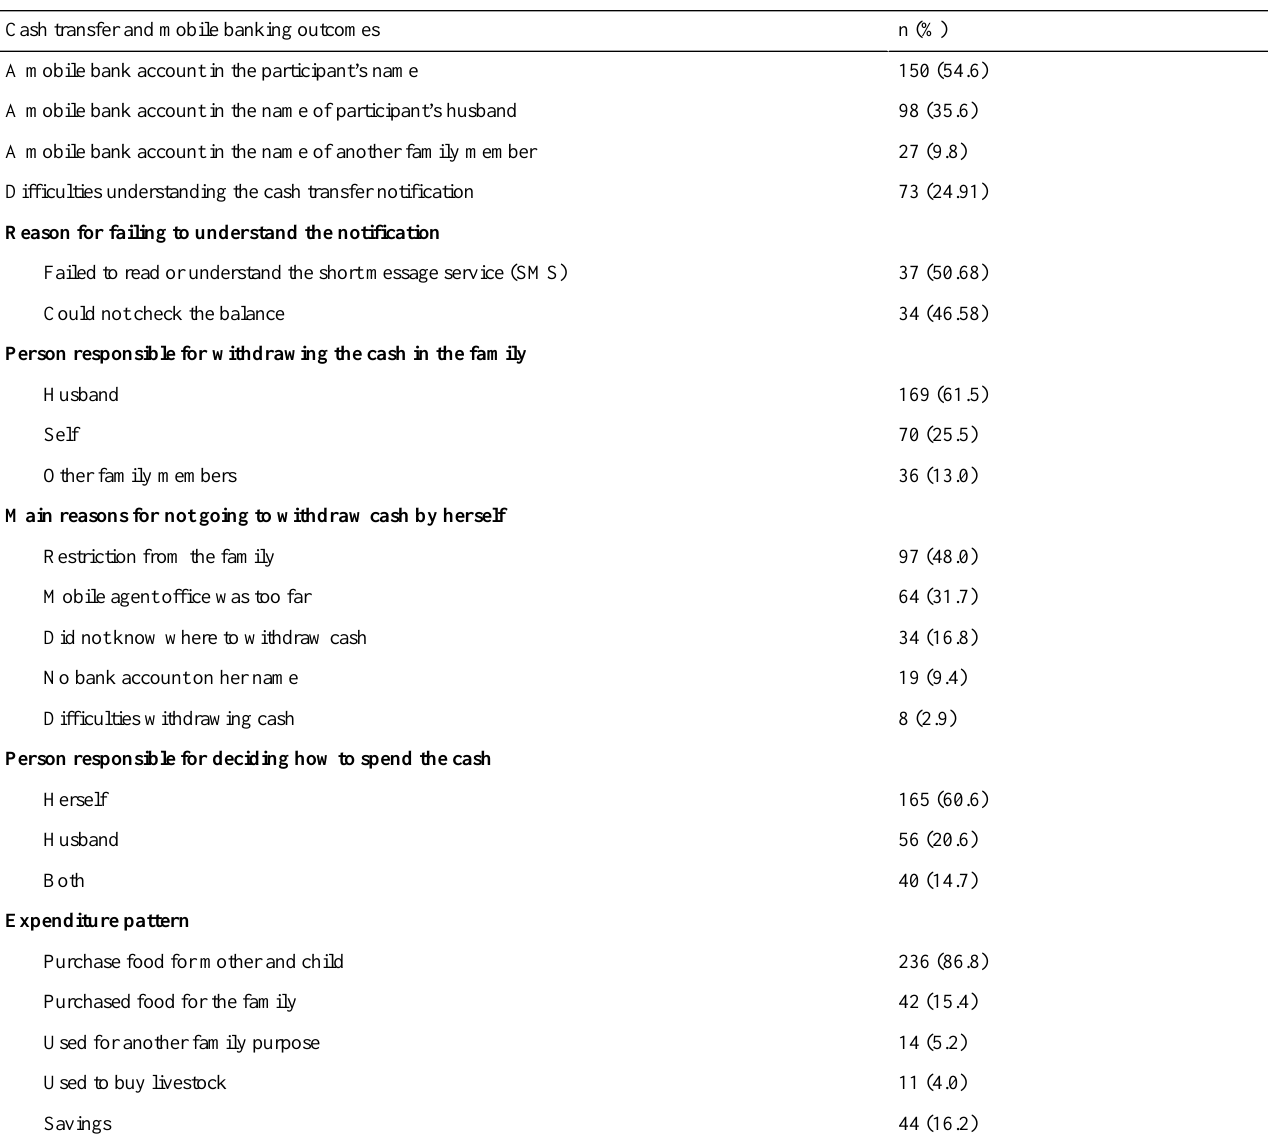
n (%)Cash transfer and mobile banking outcomes